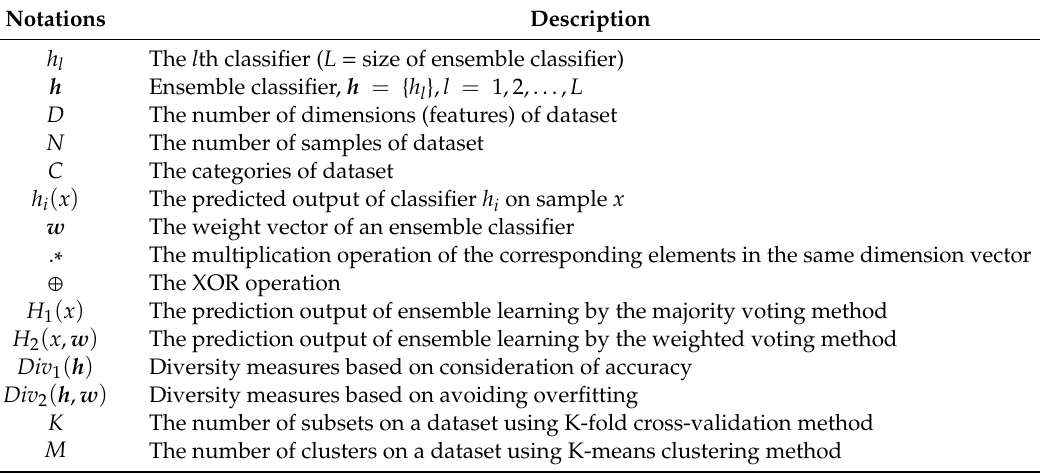
Table 1. Notations and